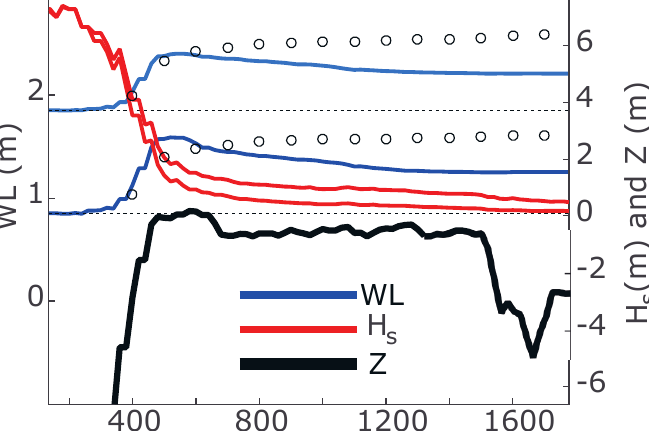
Figure 9. Ensemble (wave forcing, baseline, and SLR scenarios) significant wave heights ( H s , red) and water levels (WL, blue), along a transect through the “reef” location (shown in Figure 5); offshore is on the left side, landward direction towards the right; topography (Z) is indicated with a black line. The analytic estimate of wave setup described by Vetter et al. [8] and Becker et al. [44], based on H s from the Apia model, is plotted with black circles, with the caveat that breaking parameter λ b is set to 1.0 (consistent with the Apia model), rather than varying with water